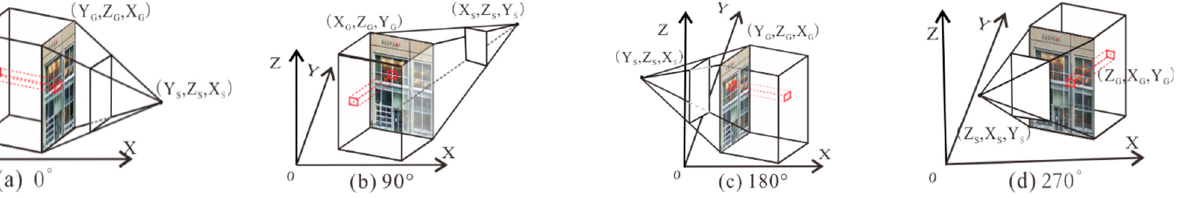
Figure 5. True three-dimensional (360°) full-circle T 2 OM generation. ( a ) Orthorectification for a building facade in 360° direction; ( b ) orthorectification for a building facade in 180° direction; ( c ) orthorectification for a building facade in 90° direction; ( d ) orthorectification for a building facade in 0° direction; ( e ) orthorectification for the building’s roof; ( f ) the generation of T 2 OM for a building after a full circle (360°) orthorectification; ( g ) explanation of a superpixel data structure.